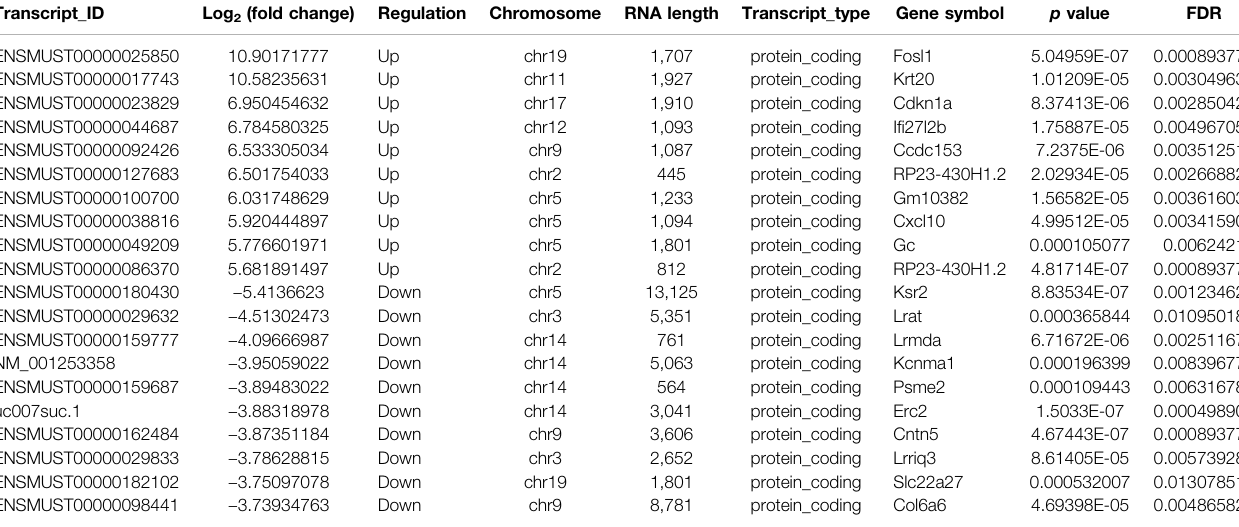
TABLE 2 | Top 20 differently methylated mRNAs in the kidneys after cisplatin treatment. Log 2 (fold change) Regulation Chromosome RNA length Transcript_type